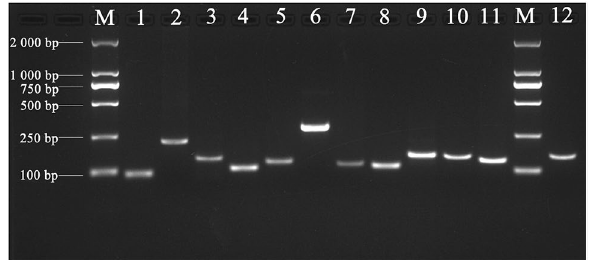
Figure 1. The PCR amplification specificities of 11 candidate reference genes and one targeted gene detected by agarose gel electrophoresis. M: DNA marker; 1: EF-1α, 2: YLS8, 3: PP2A, 4: TUA5, 5: SAND, 6: 18S rRNA, 7: